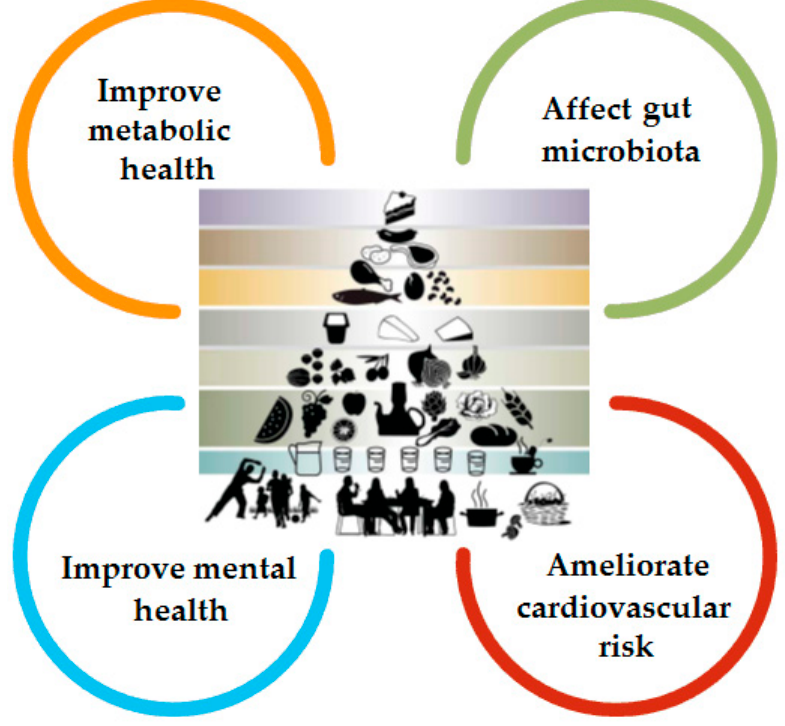
Figure 5. The benefits of MD (adapted after Bach-Faig et al.) [25].